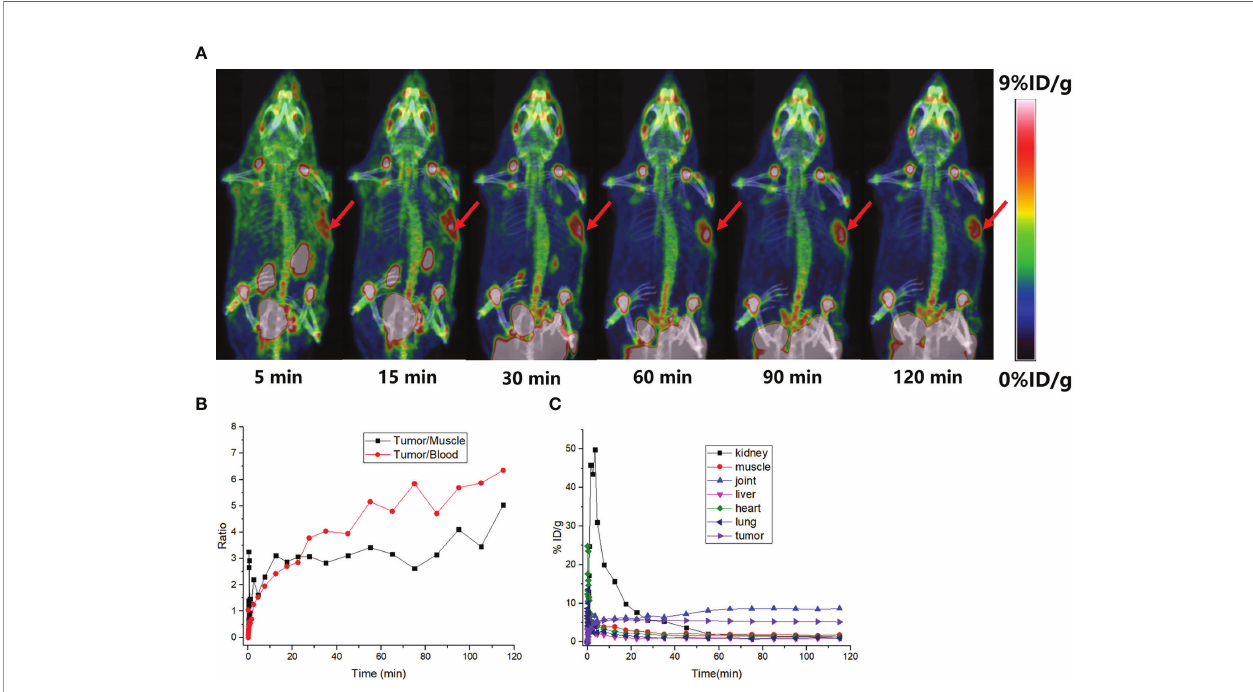
FIGURE 5 | PET imaging of small animals. (A) MIP diagrams at different time points, the red arrows points to the tumor; (B) The black curve is the ratio of tumor- muscle with time and the red curve is the ratio of tumor-blood with time; (C) The time-dependent uptake curves of different organs in the body.